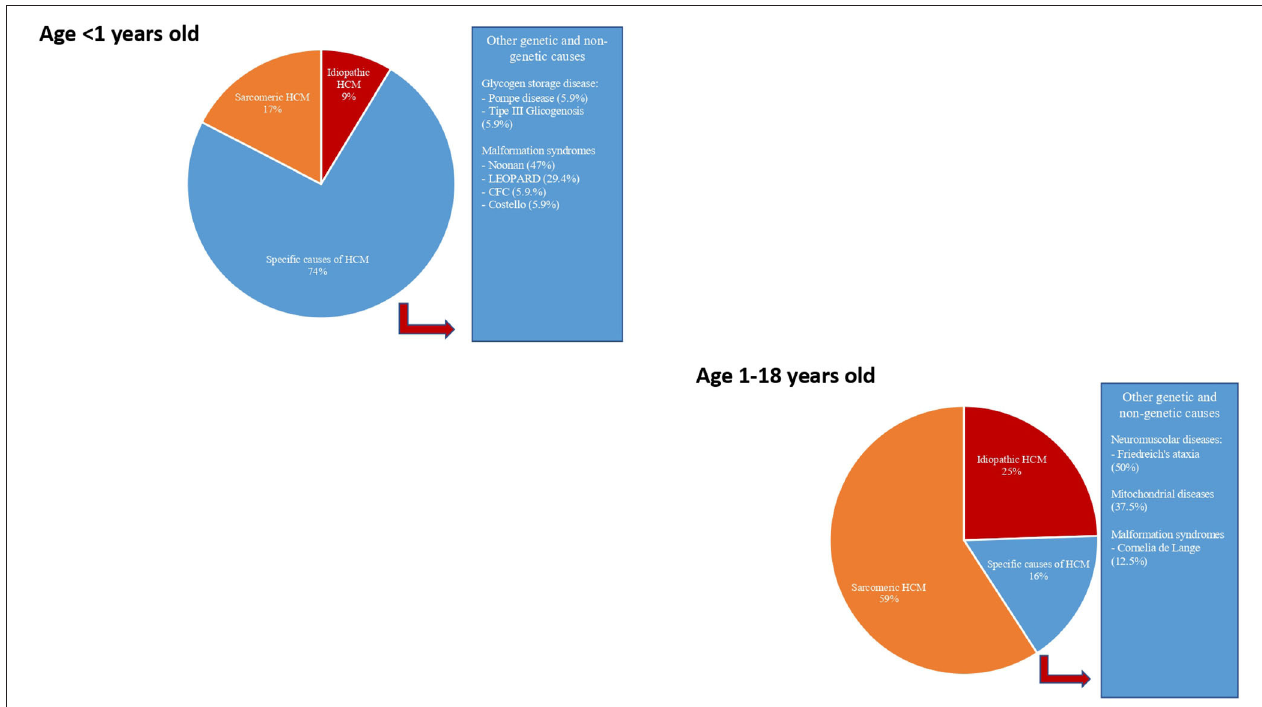
FIGURE 3 | Etiology of hypertrophic cardiomyopathy in infants (age < 1 year) and in a young child (age 1–18 years). Modified from Limongelli et al. Int J Cardiol 2020